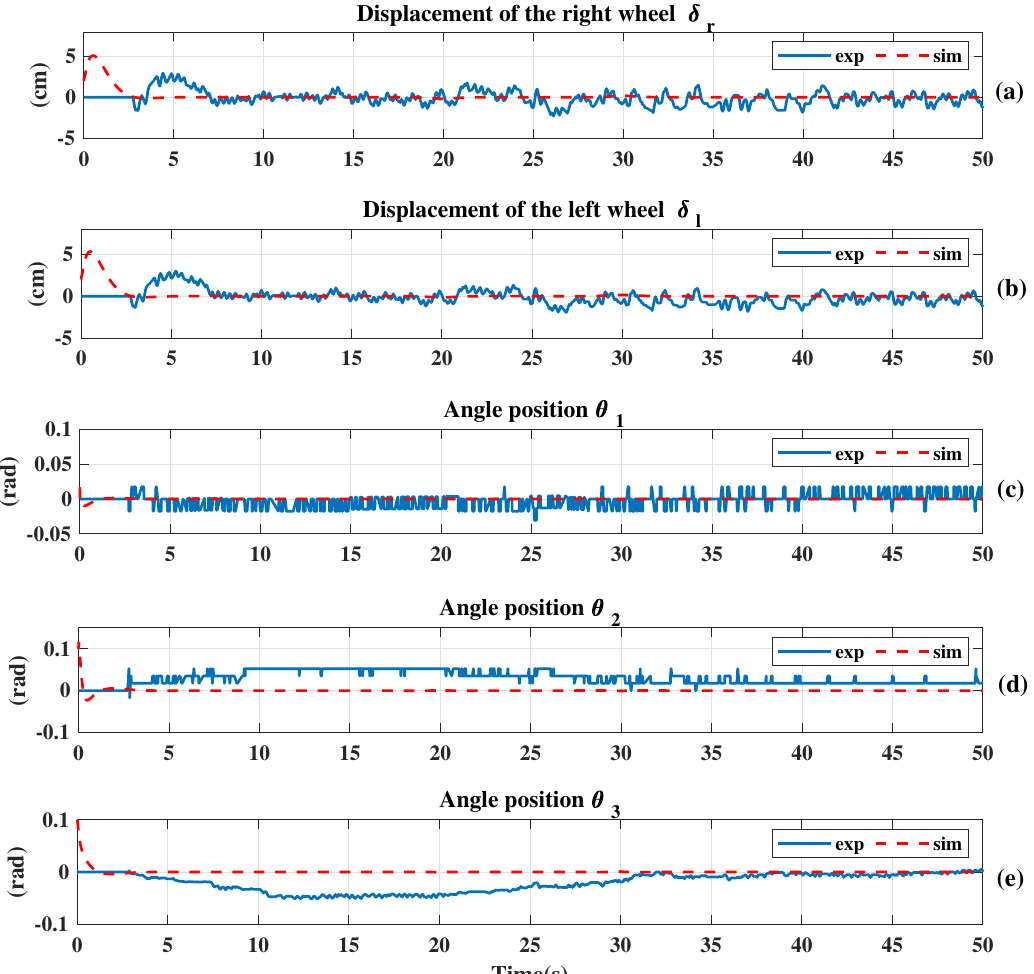
Figure 8. Response of position states: ( a ) Displacement of the right wheel δ r , ( b ) displacement of the left wheel δ l , ( c ) tilt angle of the first link θ 1 , ( d ) tilt angle of the second link θ 2 , and ( e ) tilt angle of the third link θ 3